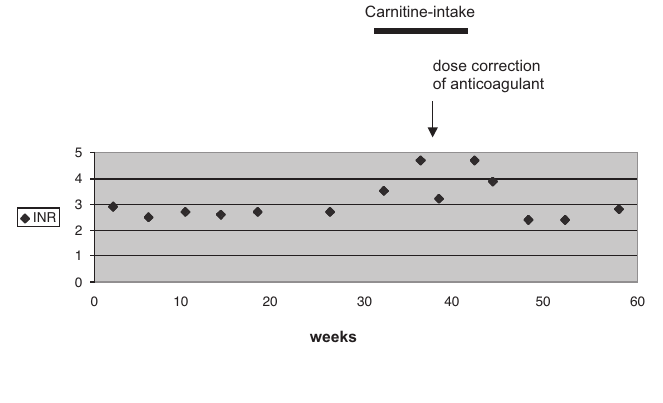
Figure 1 Timing of carnitine-intake and INR